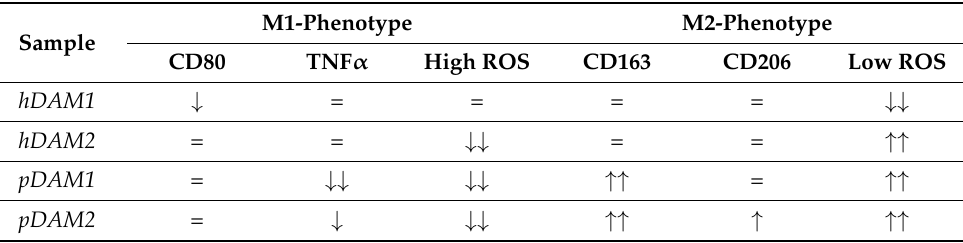
Figure 4. Percentage of proinflammatory M1 RAW-264.7 macrophages (characterized by CD80 + , TNF- α , and HIGH ROS) and reparative M2 macrophages (characterized by CD163 + , CD206 + , and LOW ROS) after 24 h of culture on human (h) and porcine (p) DAMs obtained by either enzymatic methods (hDAM1 and pDAM1) or treatment with organic solvents (hDAM2 and pDAM2). All the values are shown as percentages referred to the corresponding control value of each parameter taken as 100%. Statistical significance: *** p < 0.005, ** p < 0.01, * p < 0.05 (comparison of the results obtained in the presence of matrix with their respective controls in the absence of matrix). Table 4. Effects of hDAM1, hDAM2, pDAM1, and pDAM2 on specific markers of M1 and M2 phenotypes of RAW-264.7 macrophages exposed for 24 h to these